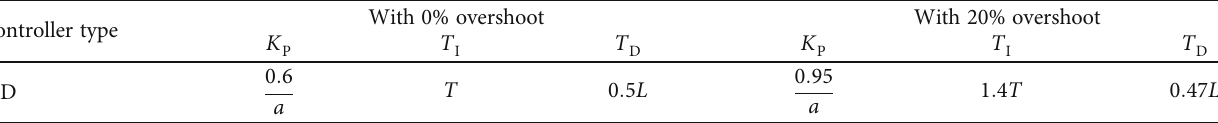
Table 3: Controller parameters for the Chien-Hrones-Reswick method.